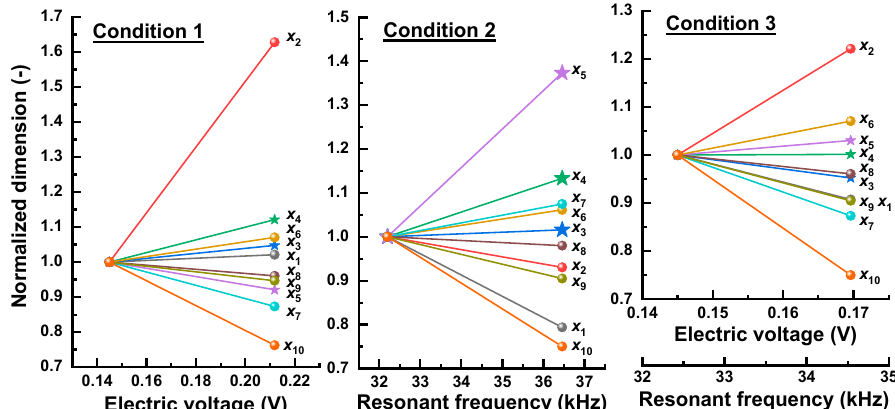
Figure 5. Variation of normalized dimension of each design variable with respect to reference design for conditions 1, 2 and 3.